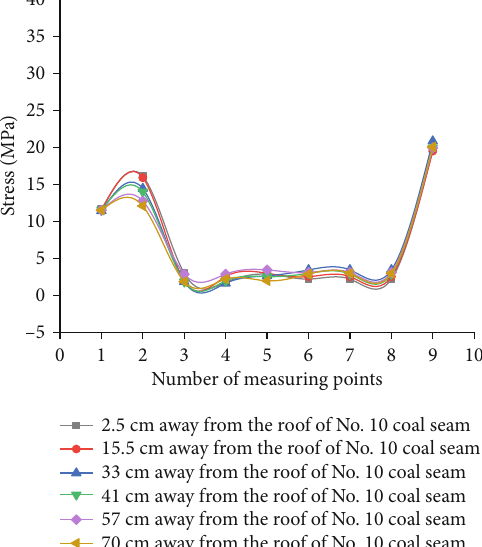
Figure 8: Stress diagram of working face mining at